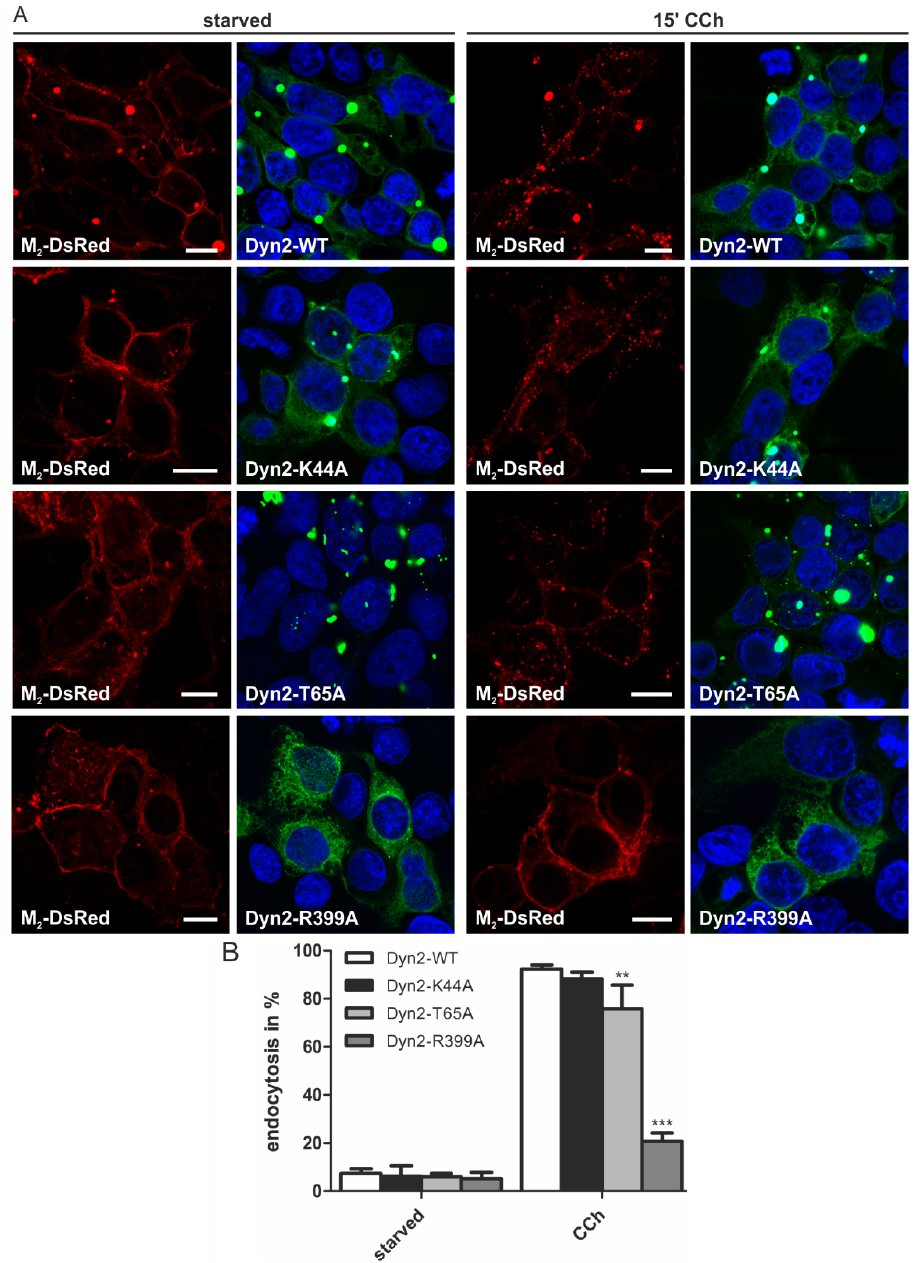
Figure 4. Dynamin mutants have different effects on the agonist-mediated M 2 endocytosis. ( A ) HEK 293T cells were transfected with M 2 -DsRed and the indicated dynamin-2-EGFP constructs. The cells were starved for 18 h in serum-free medium and either left untreated or stimulated with 1 mM CCh for 15 min. Cells were fixed, and the nuclei were stained with DAPI (shown in blue). Scale bars: 10 μ m; ( B ) The fraction of cells displaying M 2 receptor internalization was quantified and is shown as the percentage of cells exhibiting intracellular M 2 localization. At least 100 cells were counted per condition. Results are shown as the mean ± SD. Statistical analysis was performed with two-way ANOVA: ** p < 0.01; *** p <